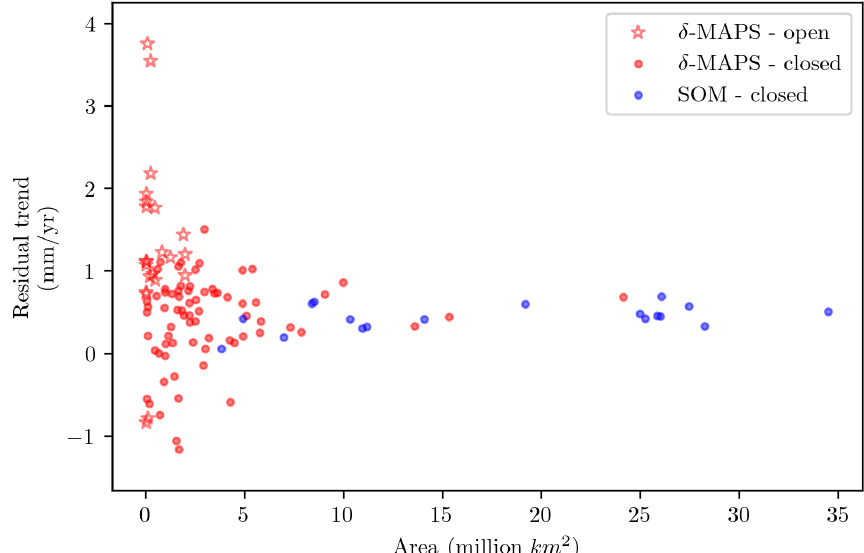
Figure A6. Scatter plot of the budget residuals (i.e. altimetry minus sum of components) against the area of each domain for δ -MAPS (red) and SOM (blue). Stars and circles indicate domains in which the sea-level budget is open and closed, respectively. As the domain area increases, the residuals converge towards 0. All the SOM residuals are within ± 1mmyr − 1 , as are 74.2% of the δ -MAPS domains.